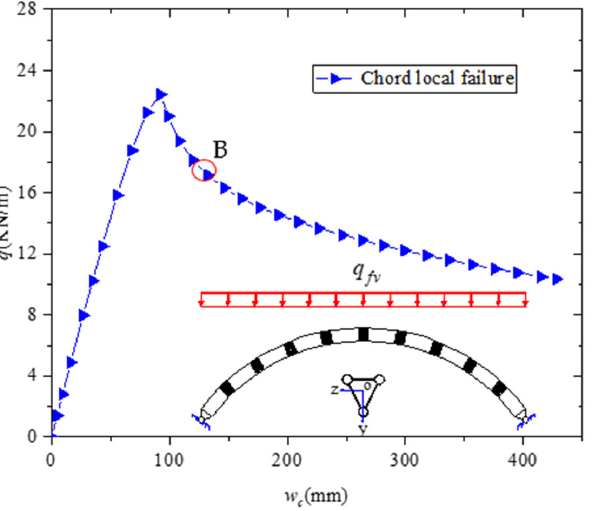
Figure 18. The vault load–displacement curve of local chord failure under FSUVL.